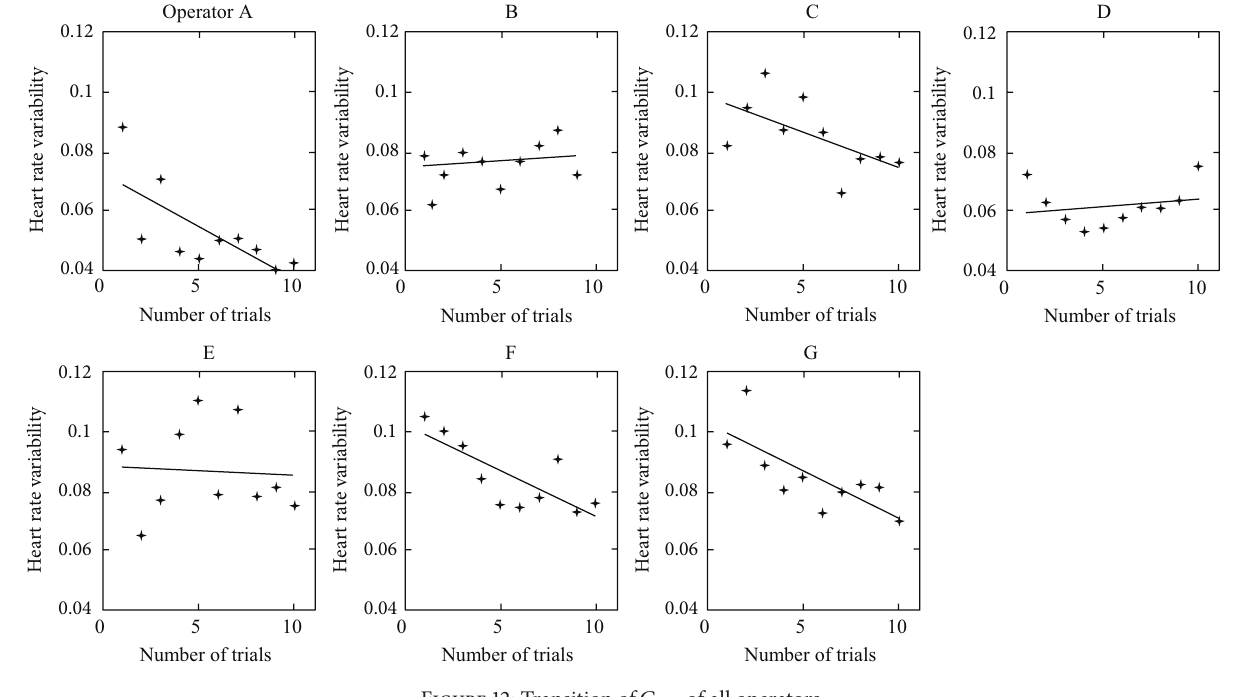
Figure 12: Transition of 𝐶